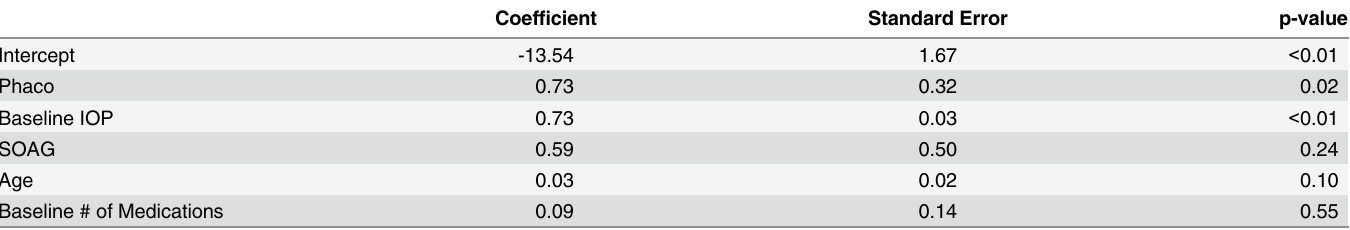
Table 4. Multivariate linear regression of patient parameters that were found to be statistically significant (p < 0.05) in univariate linear regression.